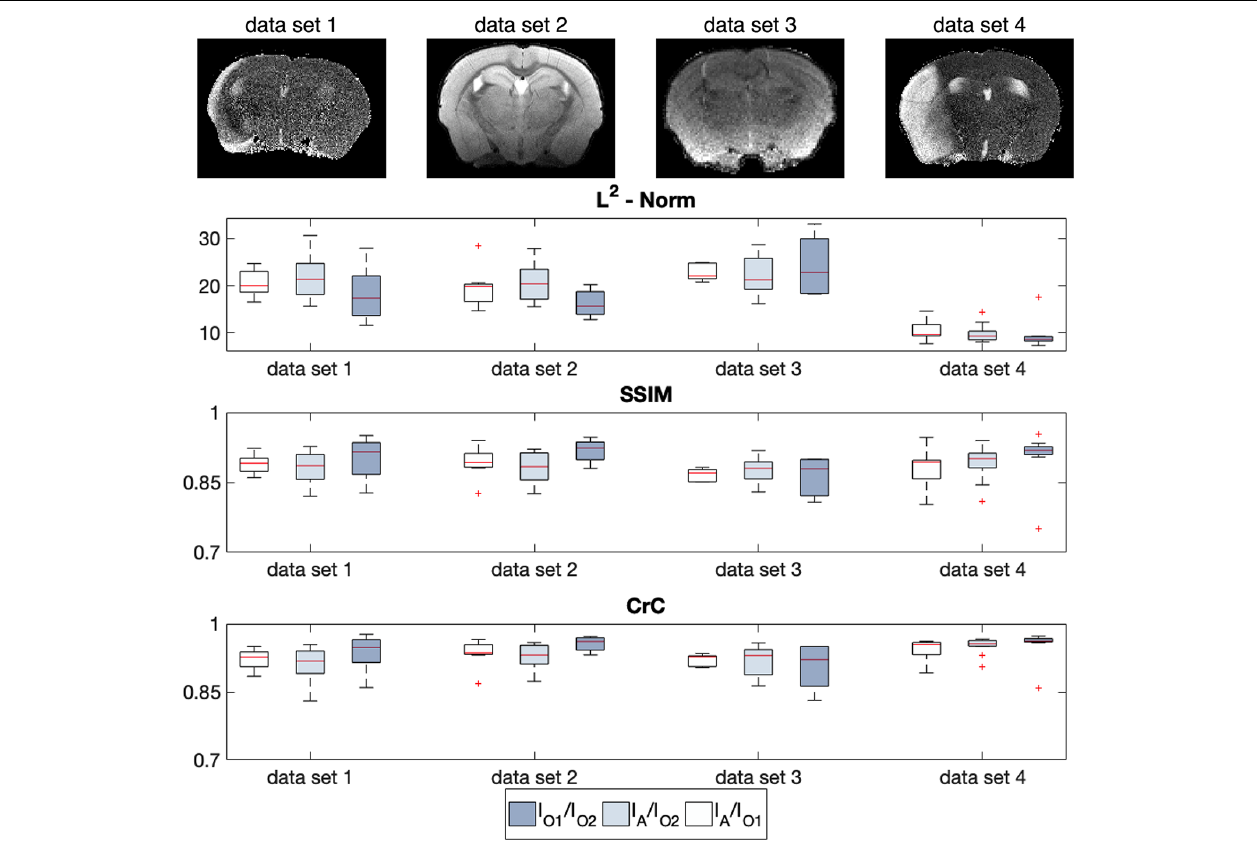
Table 2 and one example slice is shown above each evaluation. Whereas, the ground-truth was determined with the error range of I 01 / I 02 , the average error between the automated approach of AIDAmri and the observer-dependent approach I A / I 01 and I A / I 02 showed no significant differences in all three